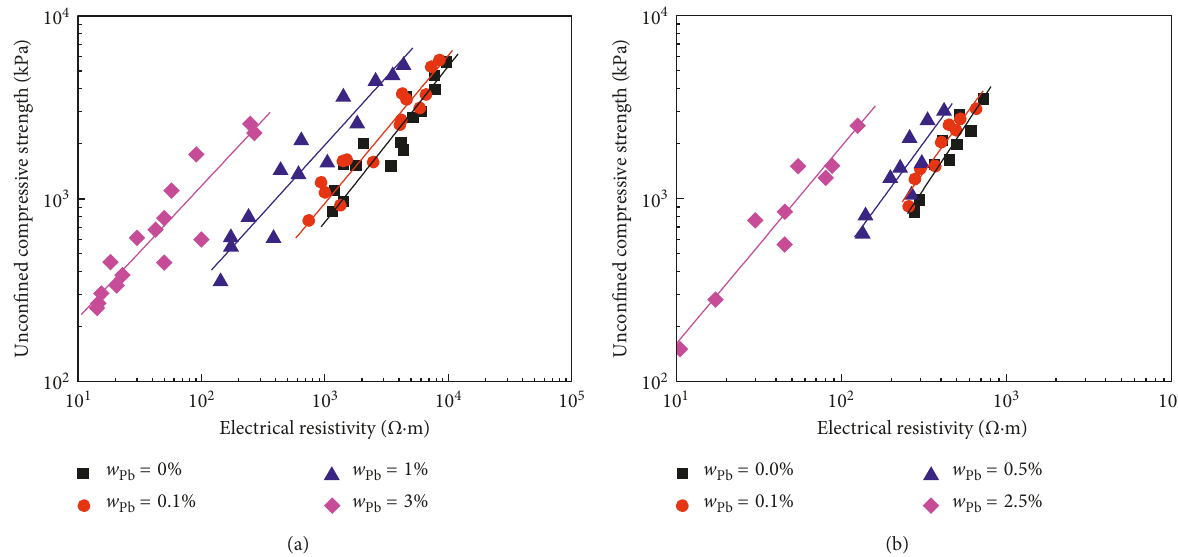
Figure 9: Relationship between unconfined compressive strength and electrical resistivity: (a) specimens of soil S1; (b) specimens of soil S2.